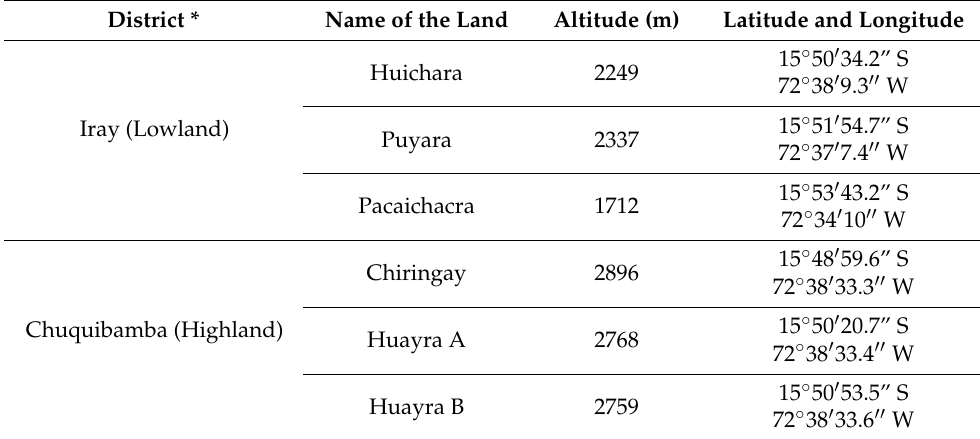
Table 4. Collected purple corn samples from lowland and highland geographical zones in